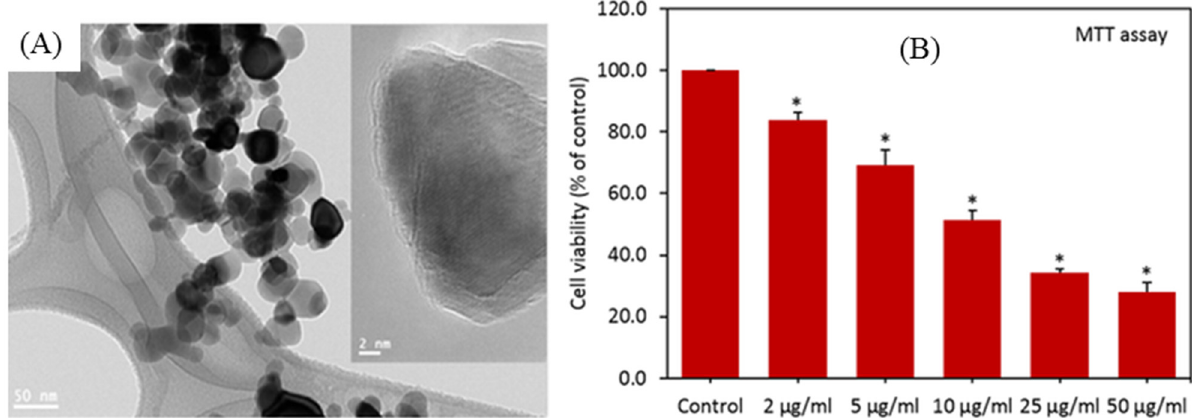
Figure 3. ( A ) Field emission transmission electron microscopy (FETEM) image